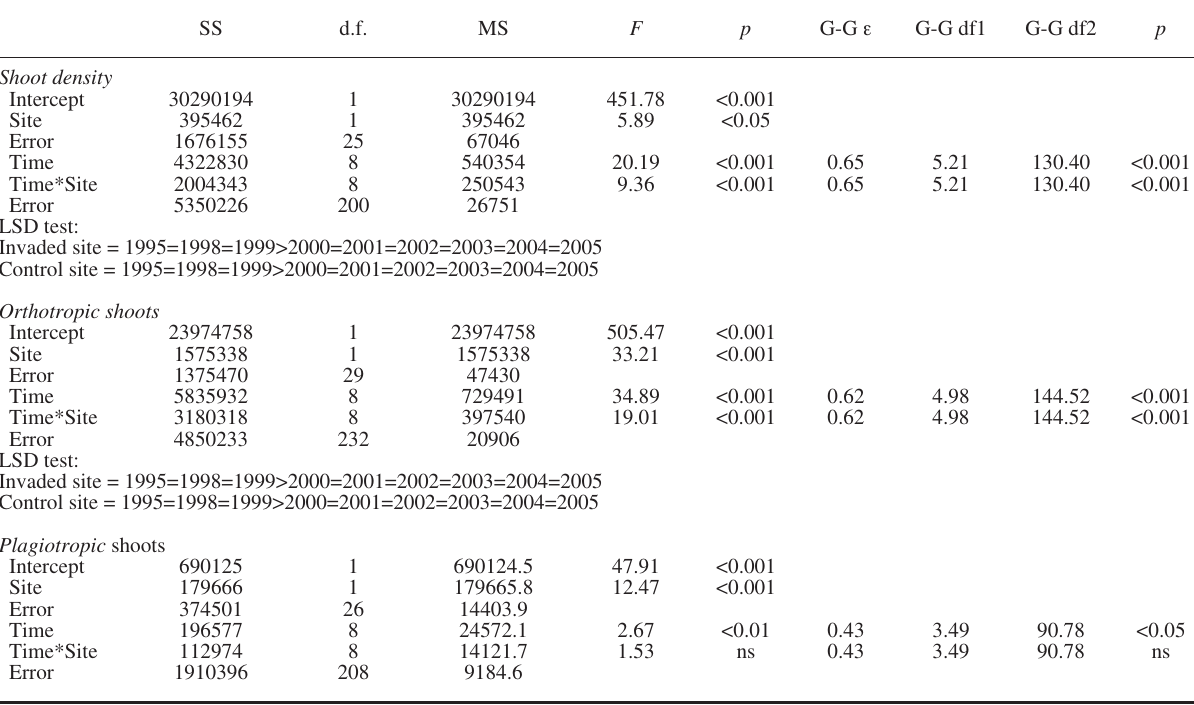
Table 1. – 2-way repeated-measures anoVa using the Geisser-Greenhouse (G-G) approximation on the effects of the site (invaded and non-invaded by Caulerpa taxifolia ) and Time on the mean shoot density, the mean number of orthotropic shoots, and the mean number of